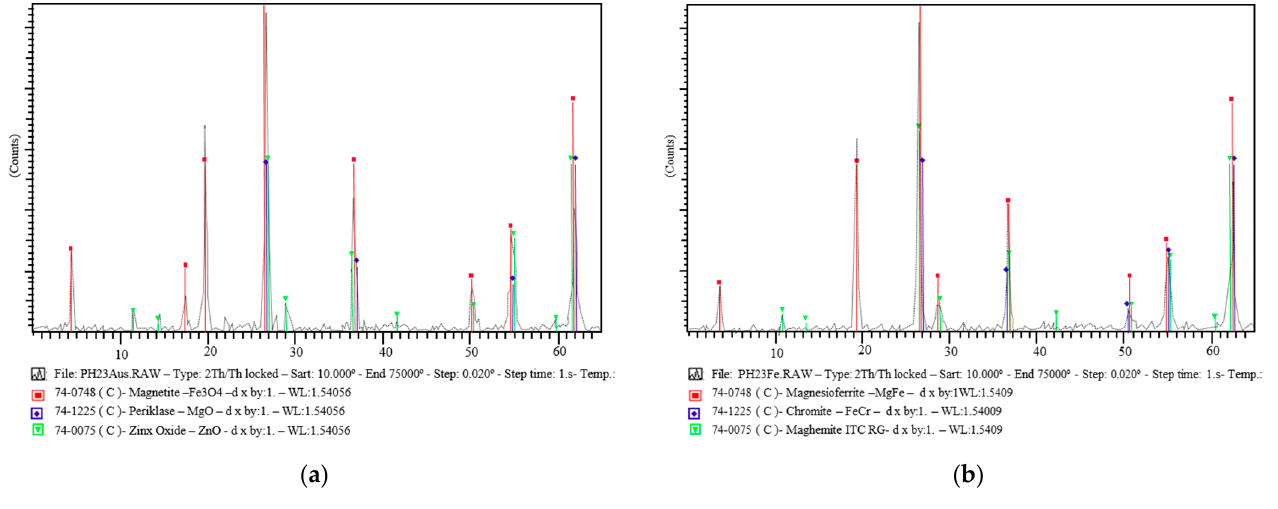
Figure 4. Diffractograms of austenitic ( a ) and ferritic ( b ) flue gas powder.